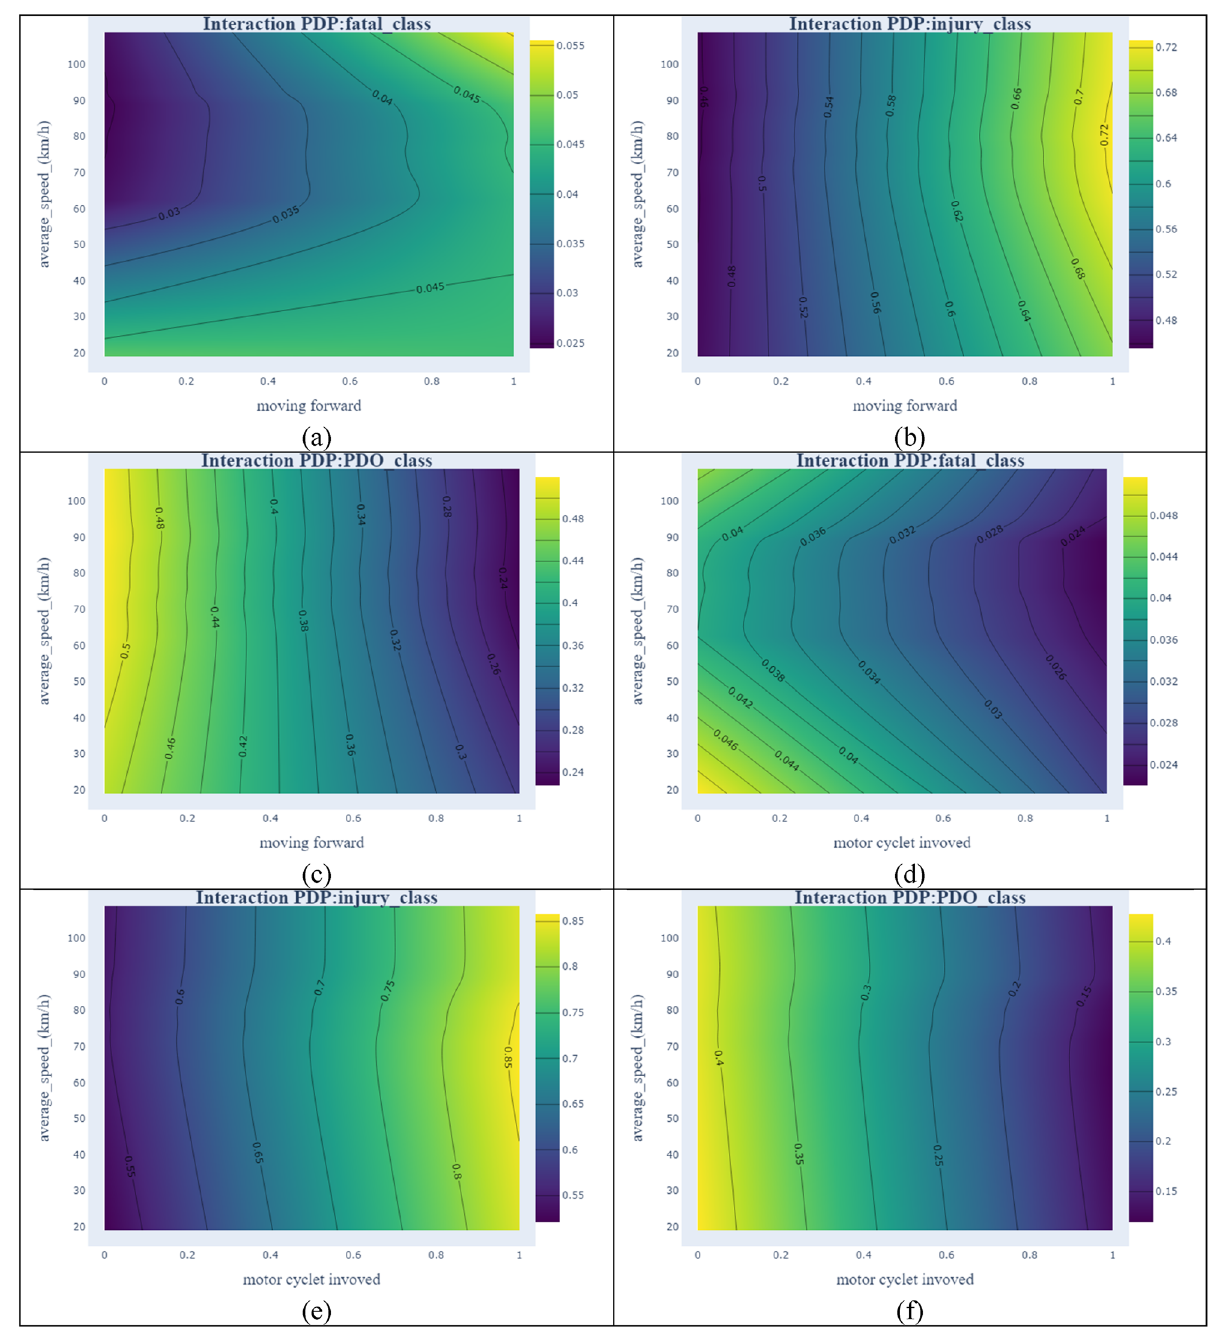
Figure 7. Interaction PDPs of selected variables with average speed [plotted by